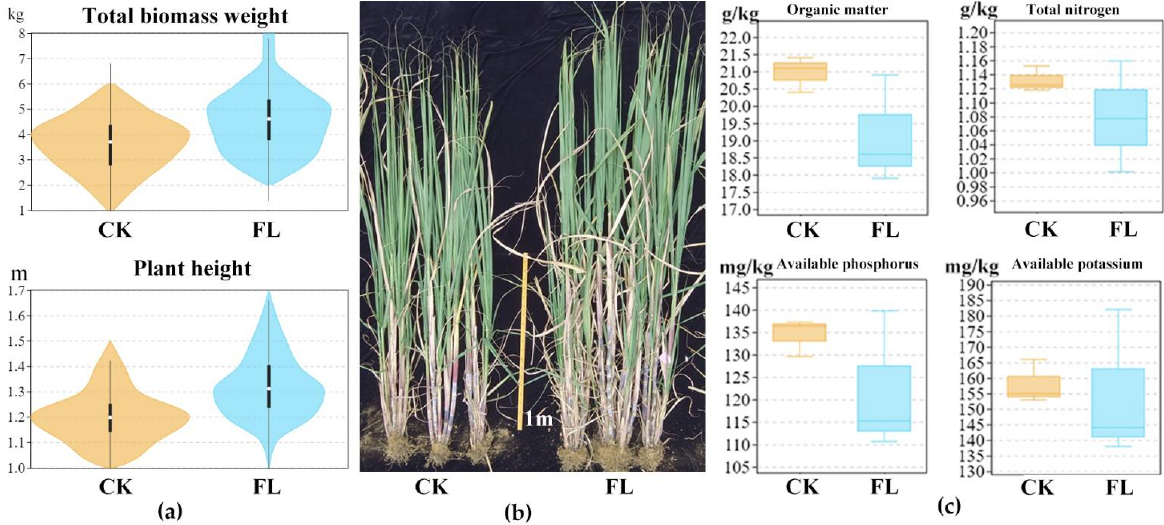
Figure 2. Improved agronomic performance and phenotypes of sugarcane plants and the soil nutrients alteration in Fenglong compared to traditional tillage. ( a ) Statistical analysis of agronomic traits of sugarcanes under conventional tillage (CK) and Fenlong (FL) at six months. The violin-shaped columns indicate the distributions of the data. The curves of the violin-shaped columns represent the probability curve of the data distribution. The number of data points at a particular value is positively correlated with the width of the probability curve. The upper and lower ends of each violin-shaped column indicate the maximum and minimum values of non-outlier data, respectively. The upper and lower edges of the vertical line in each violin-shaped column indicate the 75th and 25th percentiles of the data, respectively; and the central dot indicates the median. ( b ) Phenotypes of the sugarcane plants at six months. ( c ) Soil nutrient traits of the soils under CK and FL conditions. The box-plot shows the maximum (top whisker), minimum (bottom whisker), median (line inside the box), upper quartile (top margin of the box), and lower quartile (lower margin of the